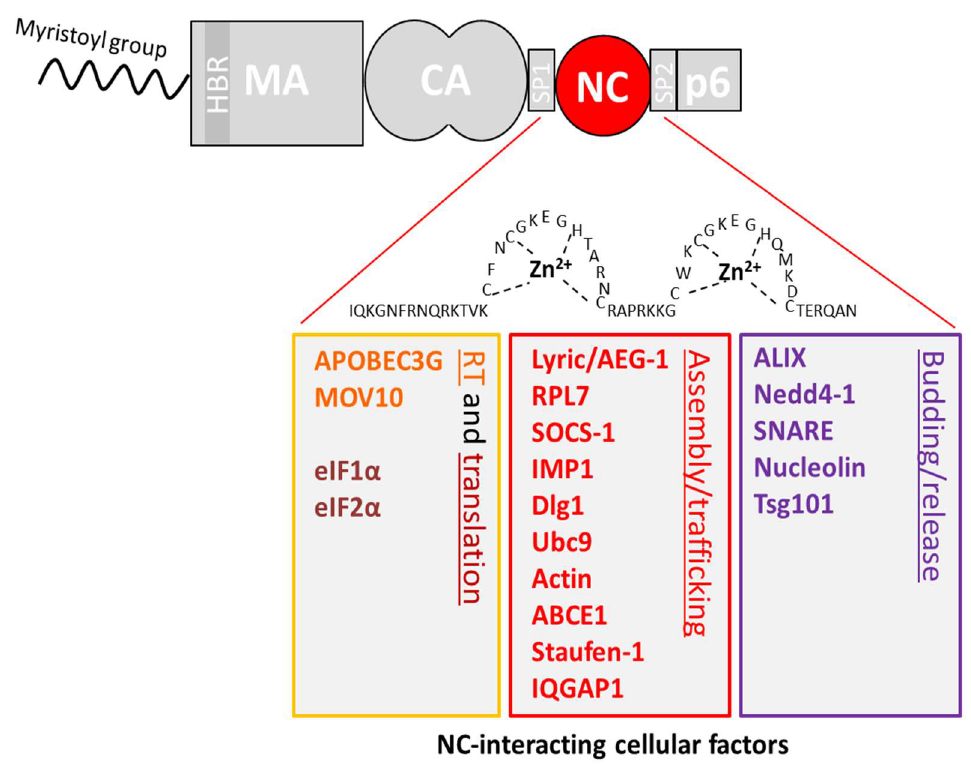
Figure 2. Zoom on the interaction of the NC domain of Gag with cellular host factors. The NC domain is highlighted, and its main cellular interacting partners are indicated.